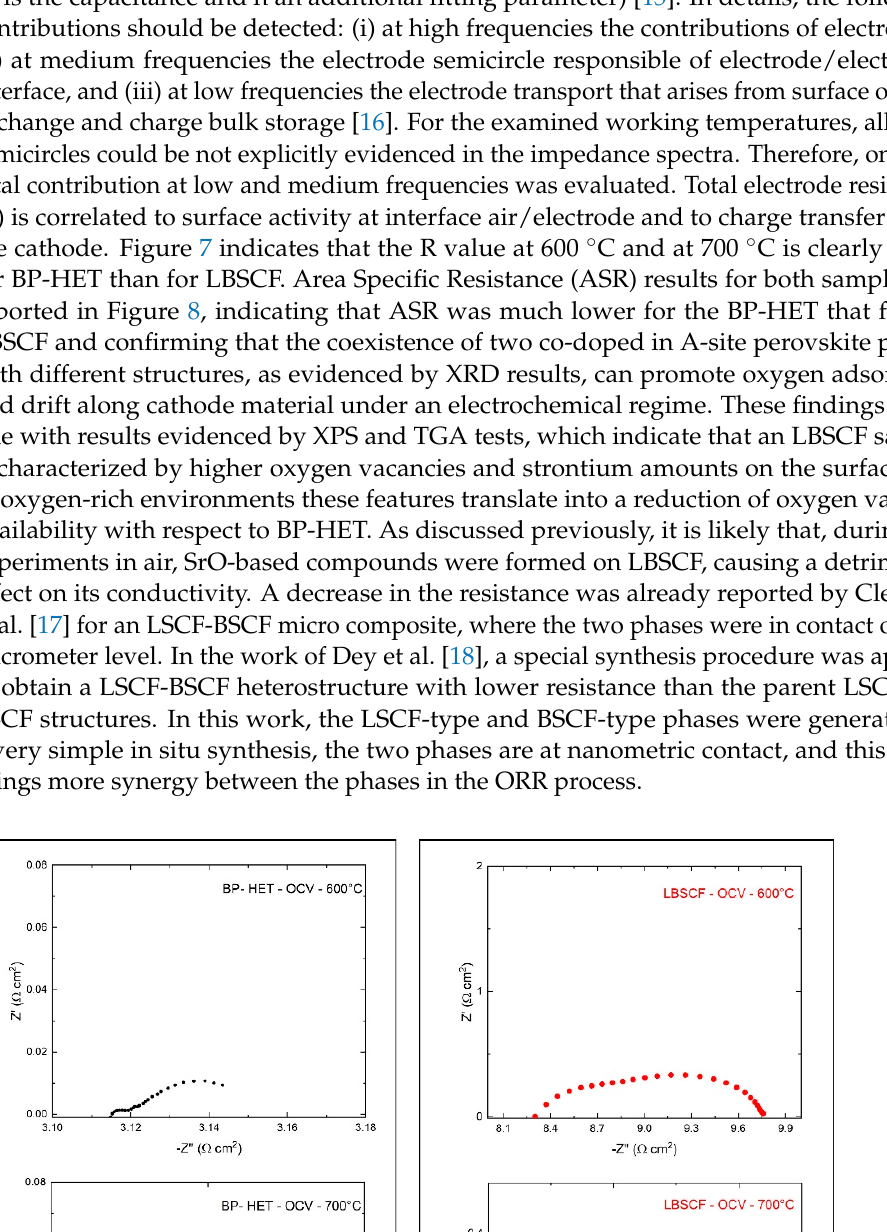
Figure 8. Area Specific resistance (ASR) for BP-HET (black line) and LBSCF (red line). 3. Materials and Methods La 0.25 Ba 0.25 Sr 0.5 Co 0.8 Fe 0.2 O 3 −δ , Ba 0.5 Sr 0.5 Co 0.8 Fe 0.2 O 3 −δ and La 0.5 Sr 0.5 Co 0.8 Fe 0.2 O 3 −δ powders were prepared by solution combustion synthesis using La(NO 3 ) 3 ·6H 2 O (99.99% Sigma-Al- drich),